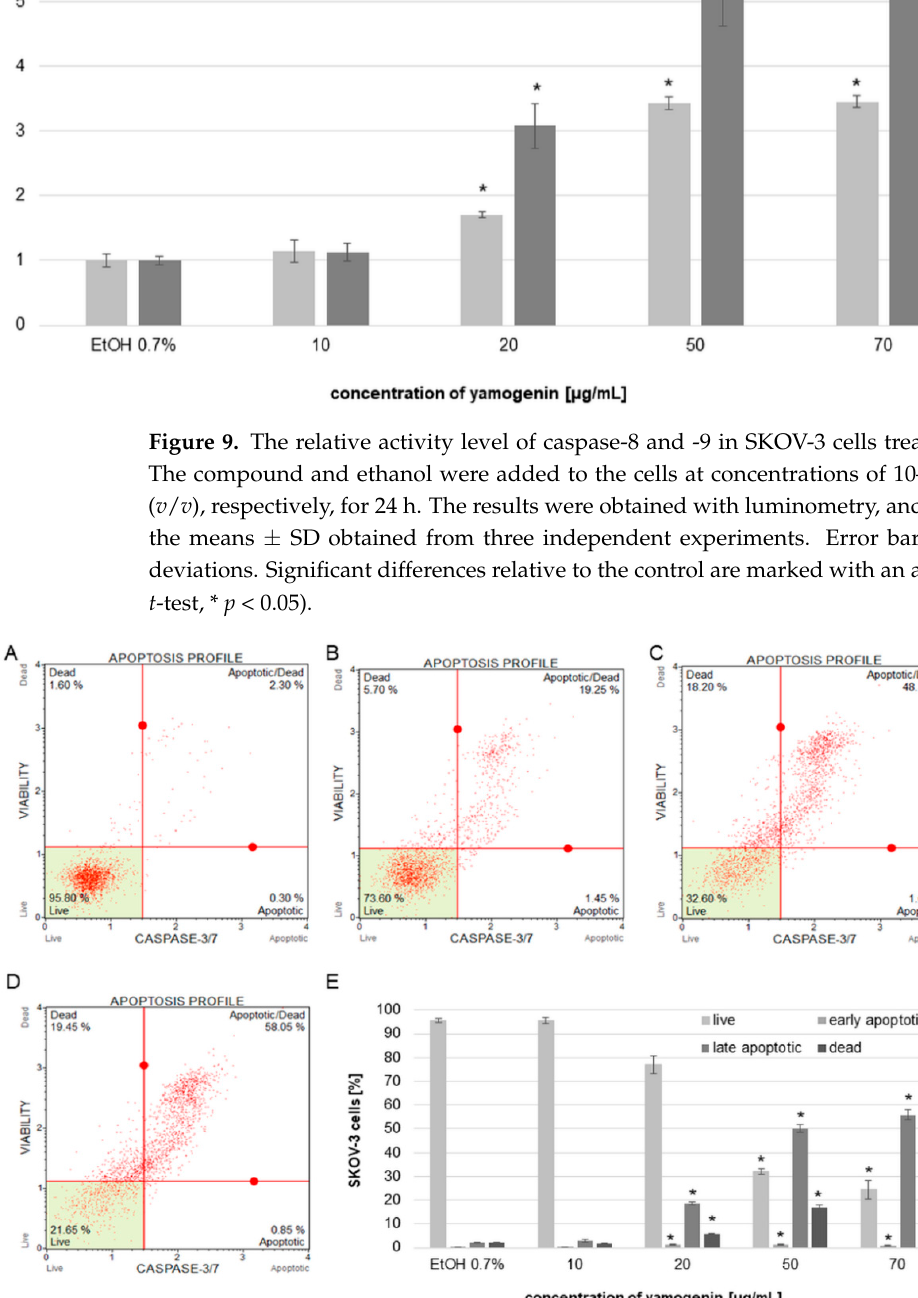
Figure 10. The activity of caspase-3/7 in SKOV-3 cells treated with yamogenin presented as per- centage of the apoptotic cell populations. The cells were incubated with ethanol (0.7% ( v/v )—a control, ( A )) and the compound at concentrations of 10, 20 ( B ), 50 ( C ), and 70 µg/mL ( D ). The amounts of live, apoptotic, and dead cells were obtained with flow cytometry and are presented as percentage of the cells in the treated population ( E ). The values represent the means ± SD of three independent experiments. Error bars represent standard deviations. Significant differences relative to the control are marked with an asterisk (the Student’s t -test, * p <